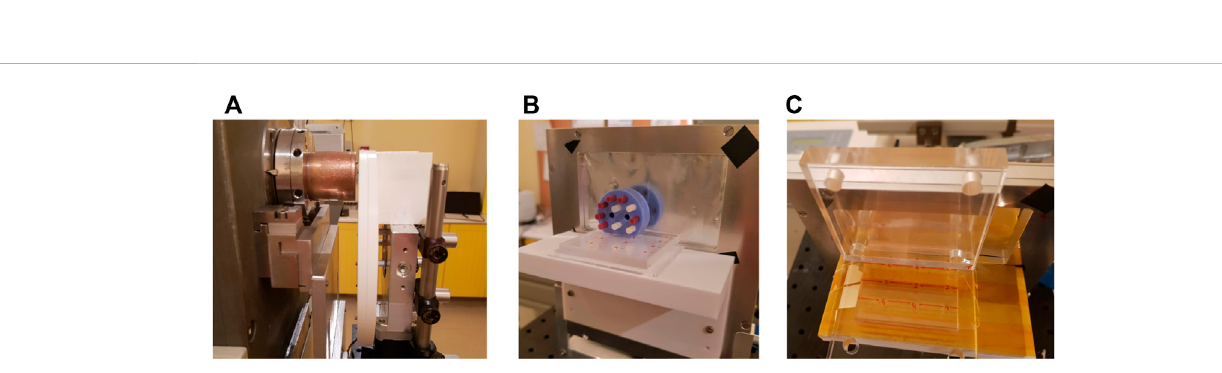
FIGURE 4 Experimental setup at CAL: (A) 3D-printed degrader wheel mounted directly after the collimator at the beam exit. (B) Detector and SmART calibration phantom. The black patches block light from entering through screw holes that lie underneath. (C) Detector and 10 mm-thick PMMA slab for